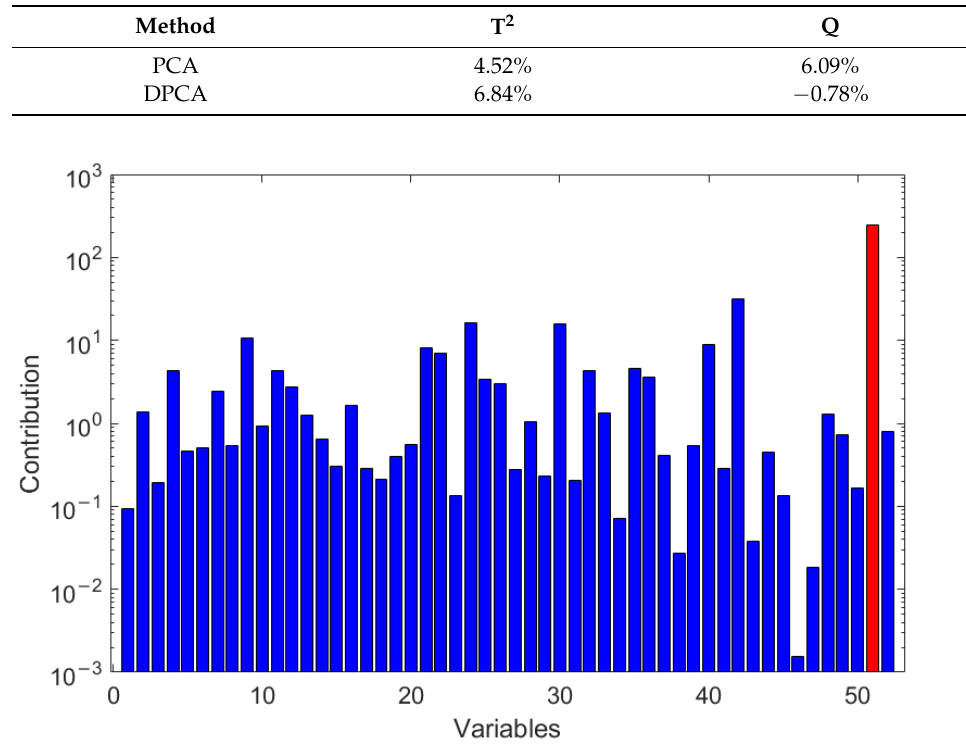
Figure 10. Contribution plots of fault 4.